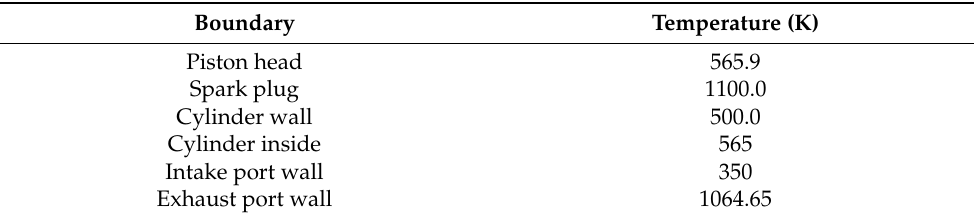
Table 4. Initial temperature of the boundary.